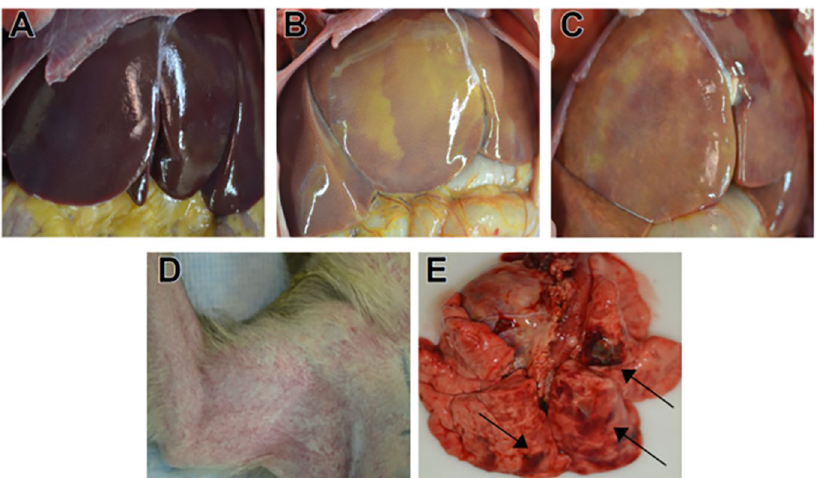
Figure 2. Representative gross pathology in cynomolgus macaques infected with EBOV Makona variant via conjunctival route. ( A ) Lack of significant hepatic lesions in a 100PFU survivor (100-5), ( B ) marked necrotizing hepatitis (500-4), ( C ) marked diffuse necrotizing hepatitis (100-4), ( D ) marked axillary petechial rash (10K-6), ( E ) multifocal hemorrhagic interstitial pneumonia (black arrows)